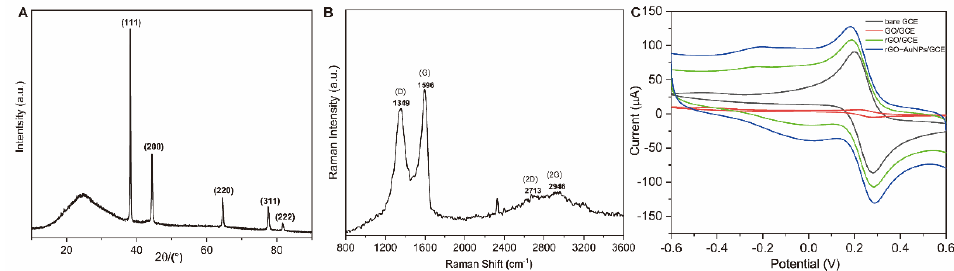
Figure 4. ( A ) X-ray diffraction (XRD) patterns of 3D-rGO/AuNPs nanocomposites; ( B ) Raman spectrum of 3D-rGO/AuNPs nanocomposites; ( C ) cyclic voltammetry (CV) curves of bare GCE, GO/GCE, 3D-rGO/GCE, and